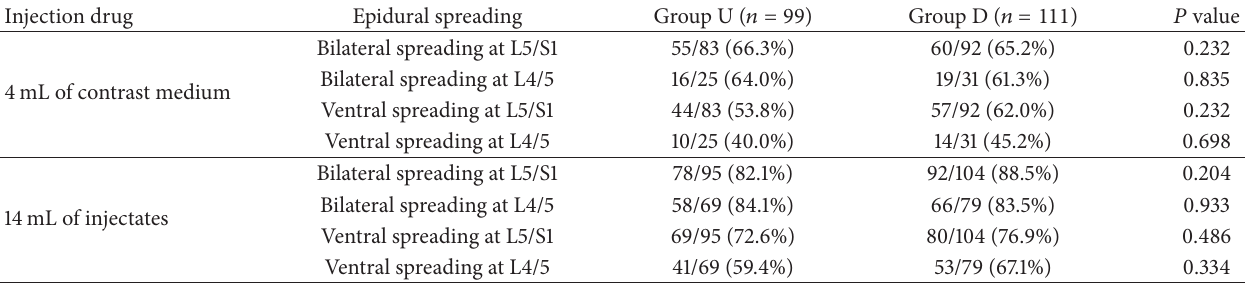
Table 5: The rates of bilateral and ventral epidural spread in groups U and D after injection of 4 mL of contrast medium or 14mL of injectates. Injection